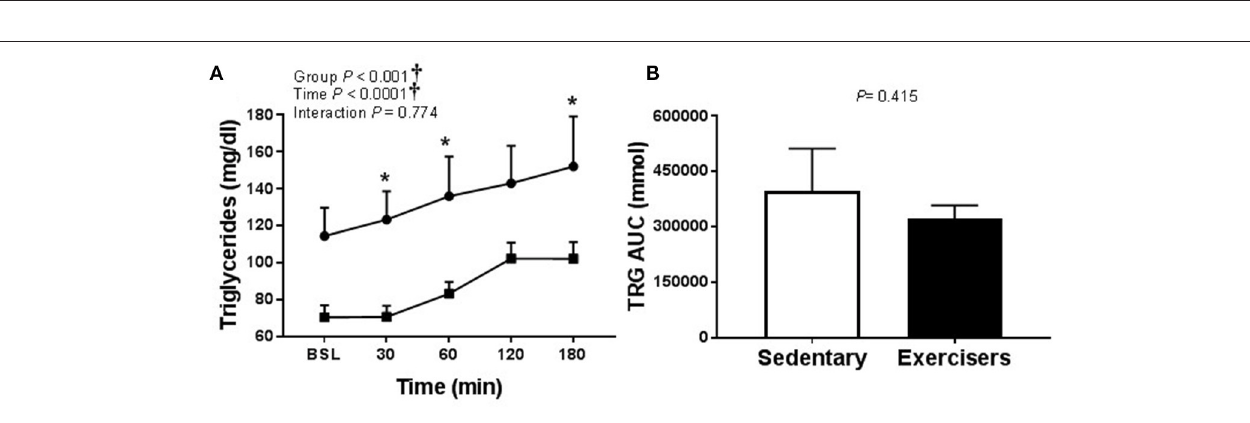
FIGURE 8 | Serum triglyceride responses to a high fat mixed meal (HFMM) at baseline, and 30, 60, 120, and 180min post-ingestion in sedentary participants ( n = 11) and exercisers ( n = 33). (A) Serum triglyceride levels over 180min. and (B) Serum triglyceride area under the curve (AUC) over the 180min postprandial period. All data presented as mean ± SEM. † Indicates significant main or interaction effect ( P < 0.05). *Indicates significant difference between sedentary participants and exercisers (adjusted P < 0.05; Sidak-Bonferroni adjustment for ANOVA multiple